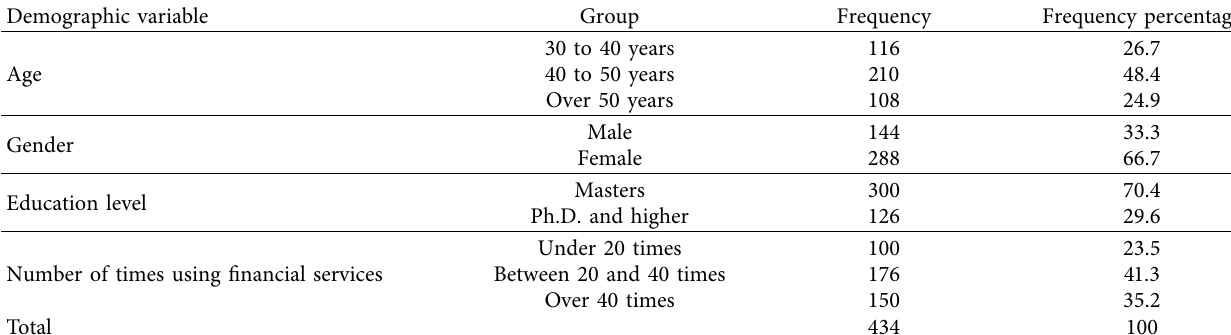
Table 2: Demographic characteristics of the statistical sample.